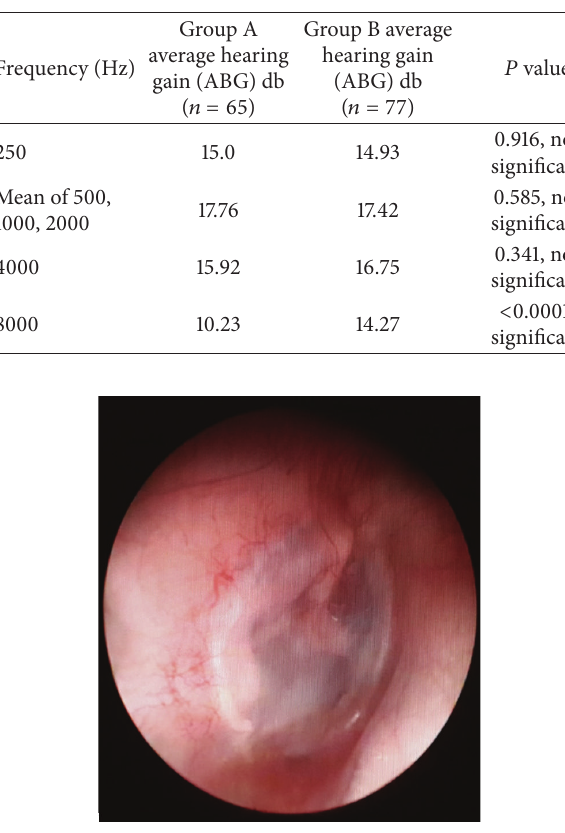
Table 2: Comparison of hearing improvement in both groups.